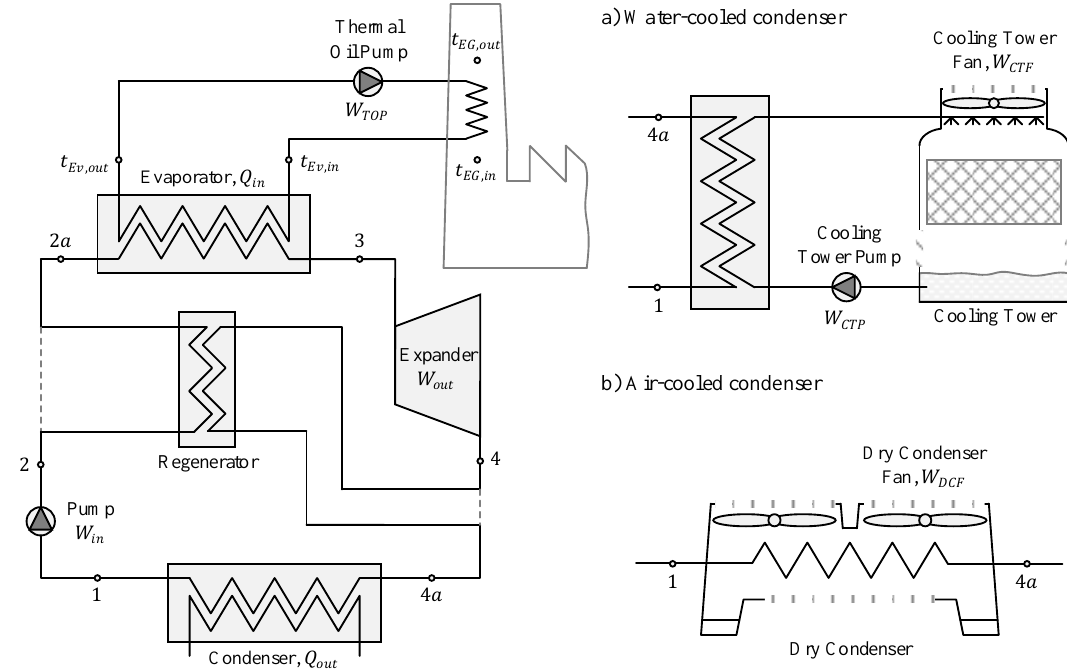
Figure 1. Main components of a power system based on the organic Rankine cycle.